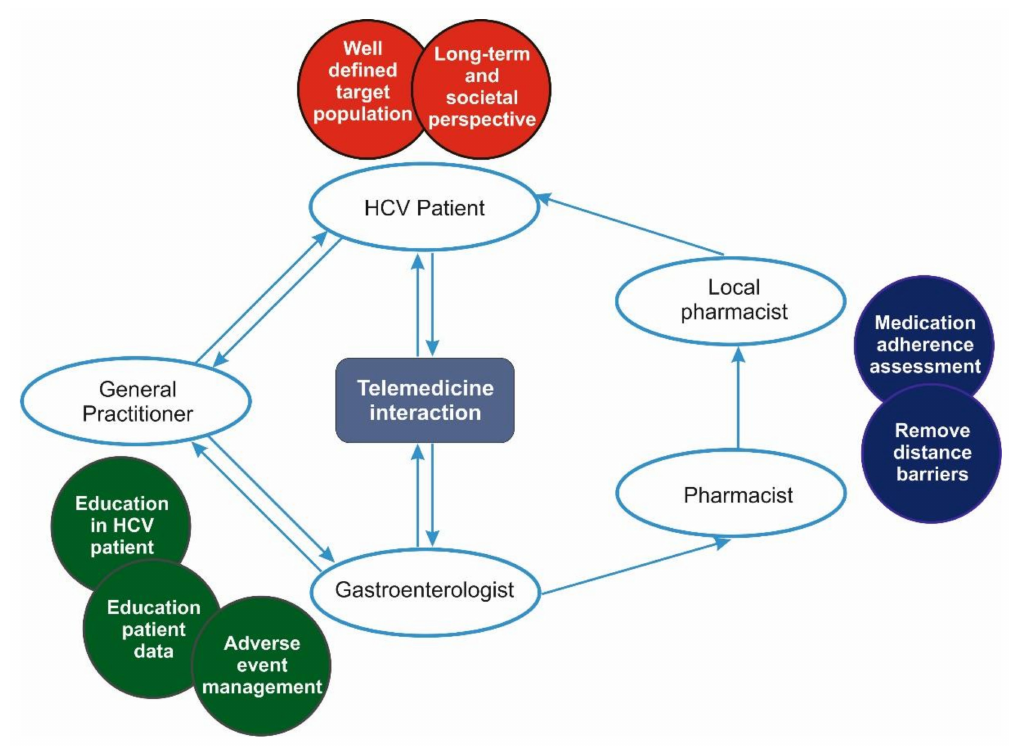
Figure 1. Study’s